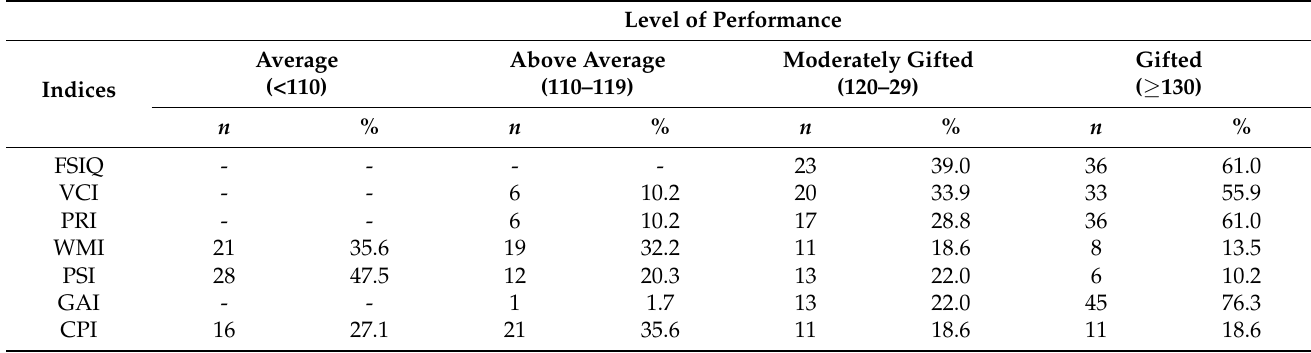
Table 2. Frequency distribution of WISC-IV indices by children’s level of